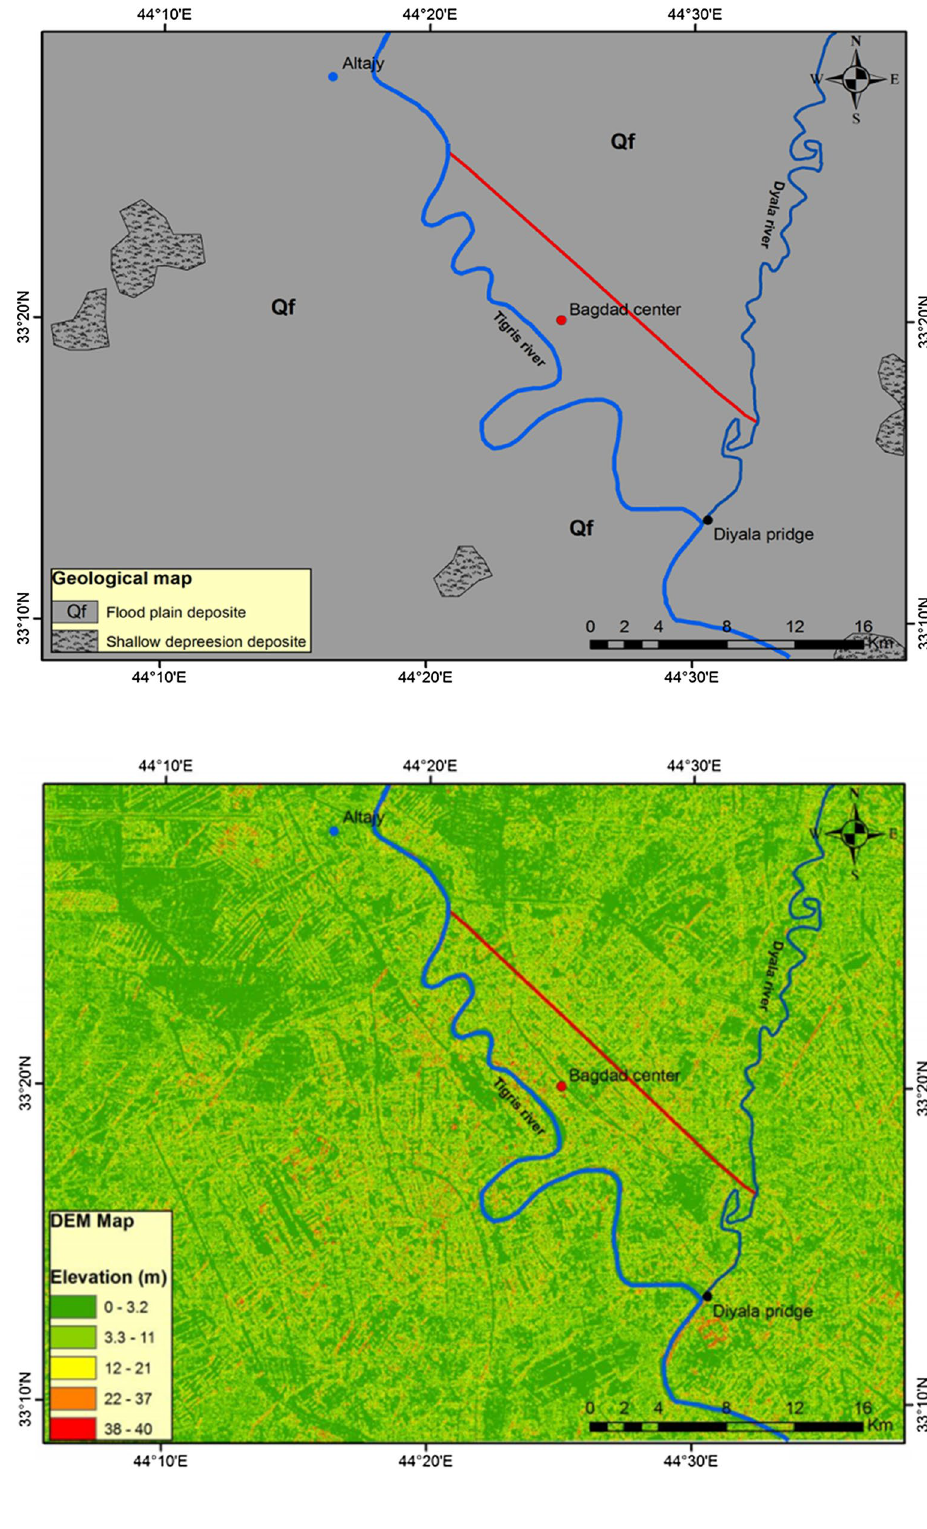
Fig. 2 Geological Map of the study area. (modified from GEOSURV, 2011)